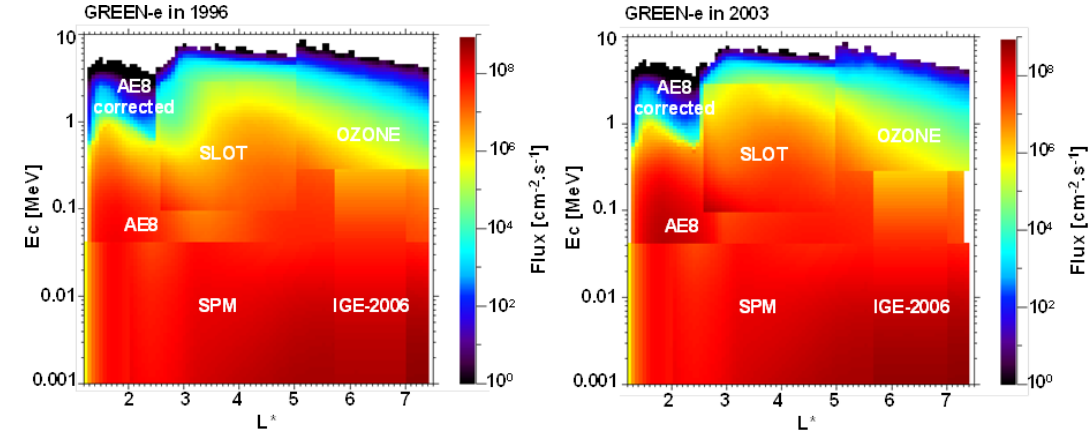
Figure 13. Electron fluxes vs. L ∗ and energy in 1996 and 2003 provided by the GREEN- e model.